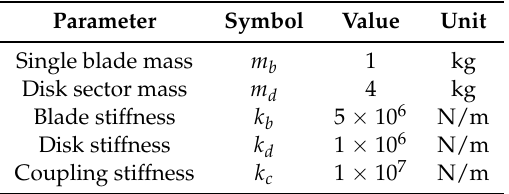
Figure 6. Natural frequencies vs. nodal diameters for the simulated mistuned bladed disk (SD = 0.10). Table 1. Parameters of the bladed disk